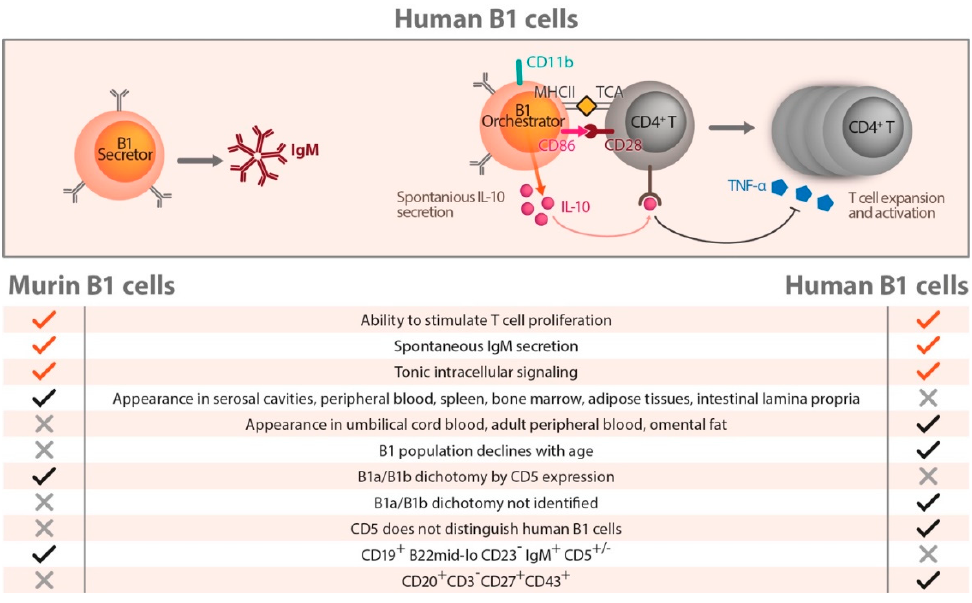
Figure 3. Characteristics of human B1 cells compared to their murine counter parts.